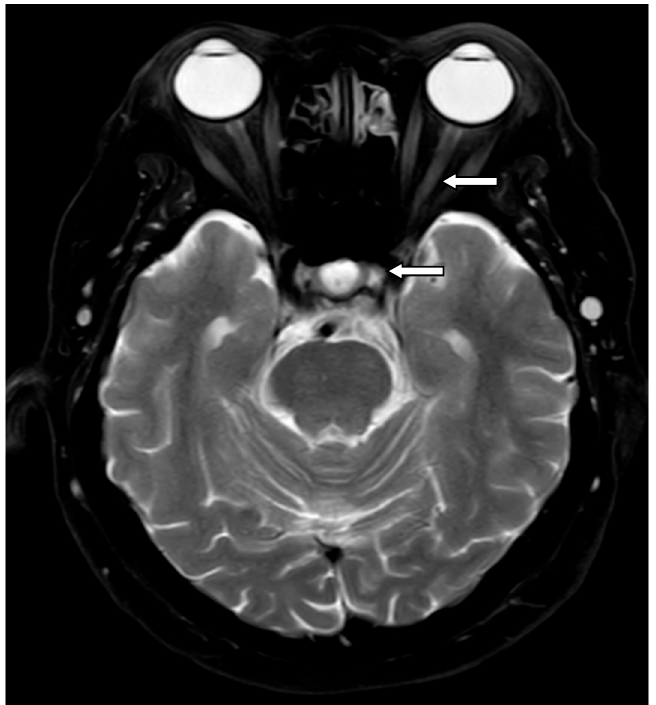
Figure 2 A female patient diagnosed with NMOSD-ON. Her MRI T2W scan showed an enhancing lesion of optic nerve at left intraorbital and optic chiasm (arrows).